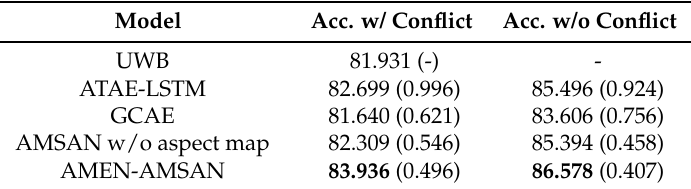
Table 2. Performance comparison of the proposed model with its baselines on the restaurant dataset of